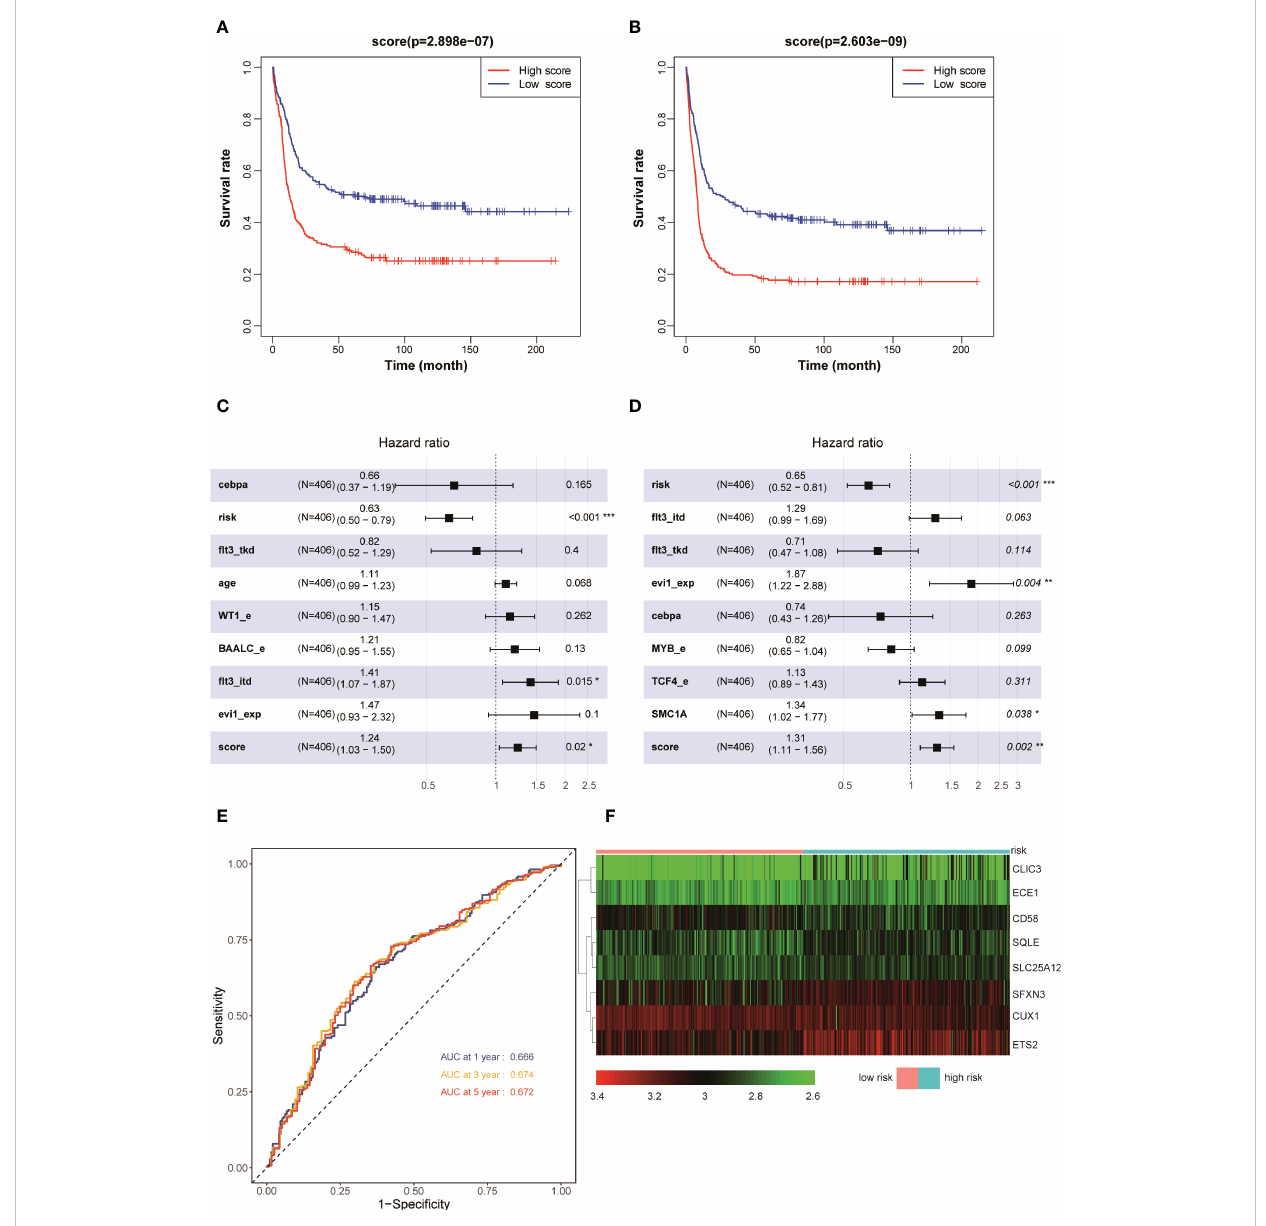
FIGURE 3 Kaplan – Meier survival curves of AML patients with high and low risk scores in GSE6891: (A) OS and (B) EFS. Multivariate analyses of clinical outcomes for patients with AML in GSE 6891: (C) OS and (D) EFS. (E) ROC curves for predicting 1-, 3-, and 5-year survival in the validation set. (F) Heat map of the eight scoring model genes in GSE6891. *p < 0.05, **p < 0.01, ***p <